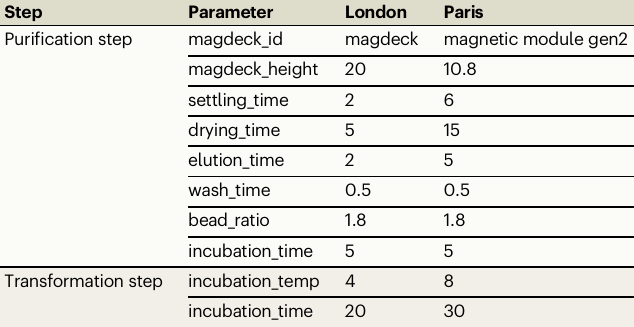
Table 2 | DNA-Bot parameters that differ between Imperial College (London) and Micalis Institute (Paris)